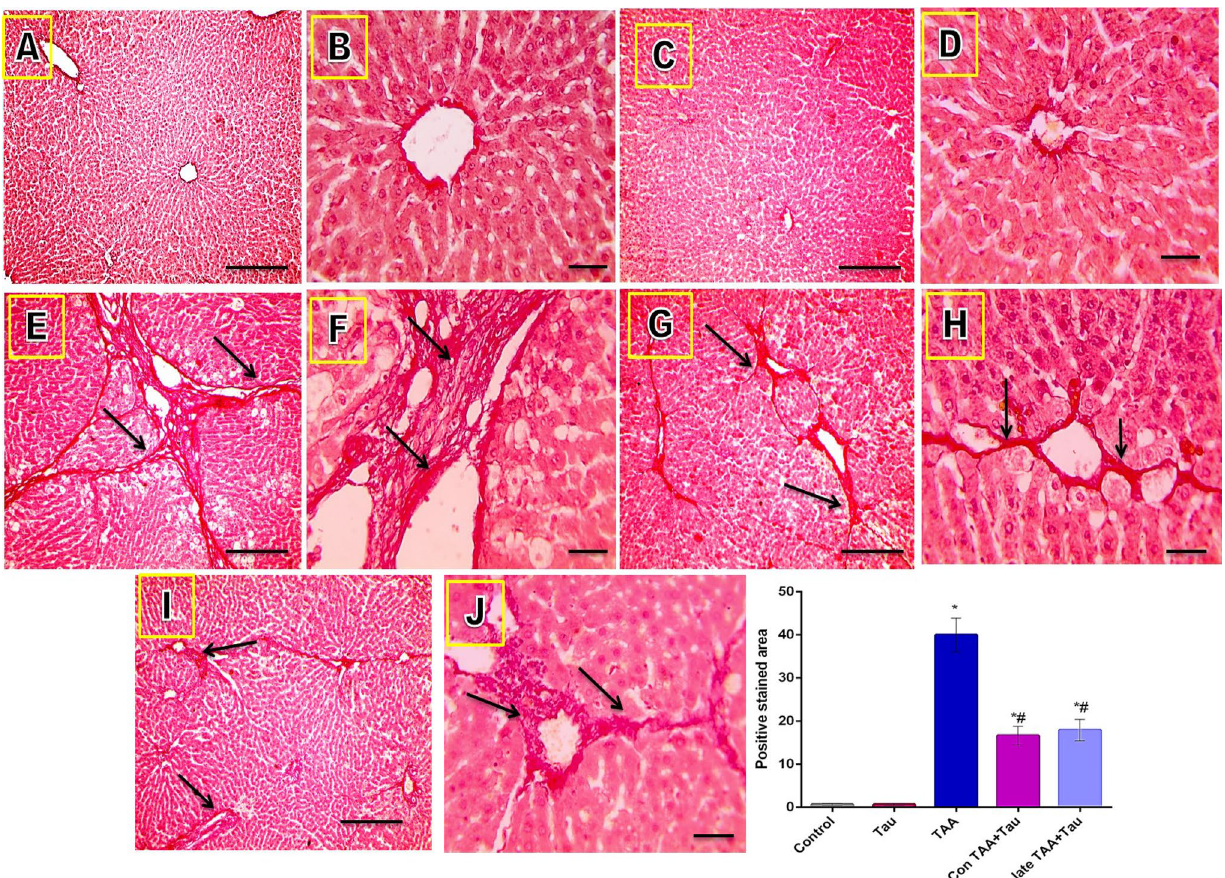
Figure 5. Microscopic pictures of Sirius red stained liver sections. ( A ) control group. ( B ): Tau group. ( C ) TAA group. ( D ) Con TAA + Tau group. ( E ) late TAA + Tau group. ( F) positive stained area. ( A,C,E.G,I ) X: 100 bar 100. ( B, D,F,H,J) X: 400 bar 50. *: Significance against control group ( P < 0.05), #: Significance against TAA group ( P <